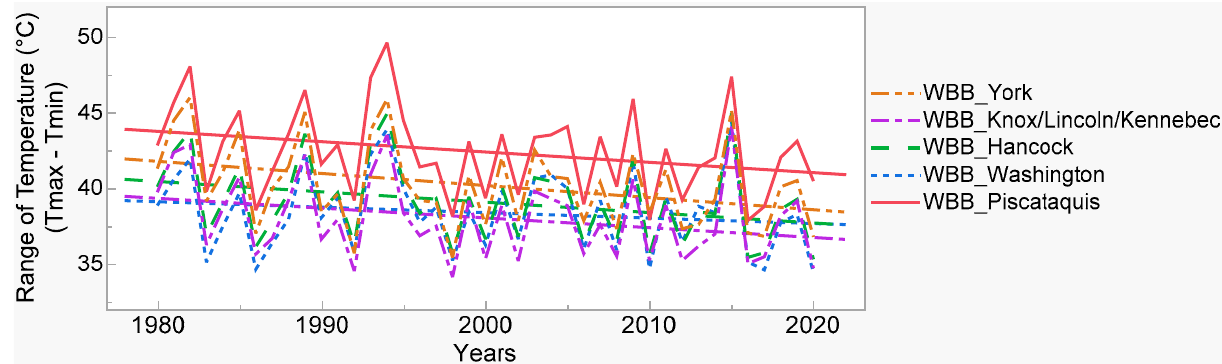
Figure 8. Historical (1980 to 2020) changes with fitted linear regression trendlines for the temperature range (difference between maximum temperature in summer and minimum temperature in winter throughout the studied wild blueberry barrens (WBBs) in different counties from north-central (Piscataquis) and north-east (Washington, Hancock) to south-west (Knox, Lincoln, Kennebec, York) of Maine as shown in Figure 1.